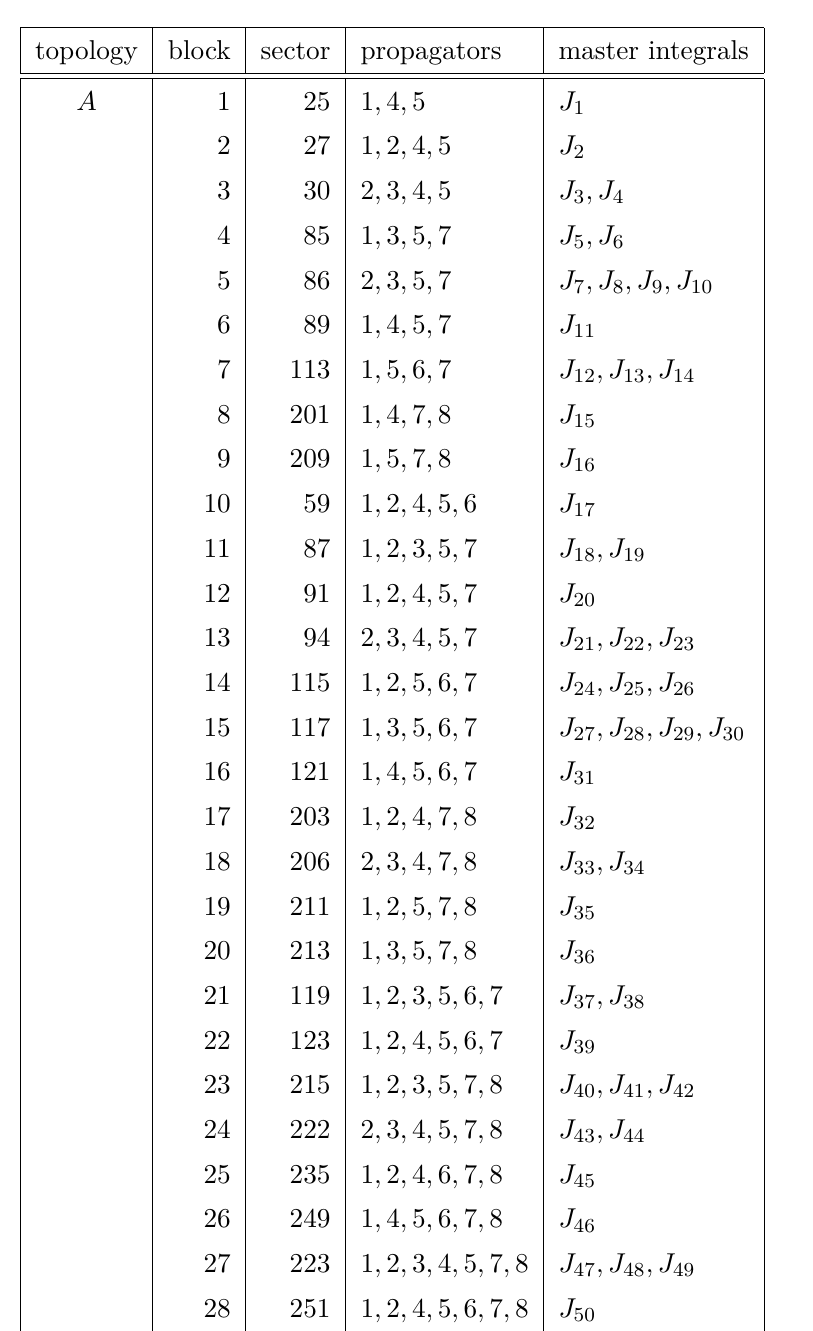
Table 3 . Overview of the set of master integrals. The first column denotes the topology, the second column labels consecutively the sectors, the third column gives the sector id (defined in eq. (2.7)), the fourth column lists the propagators with positive exponent, the fifth column lists the master integrals in the basis ~J